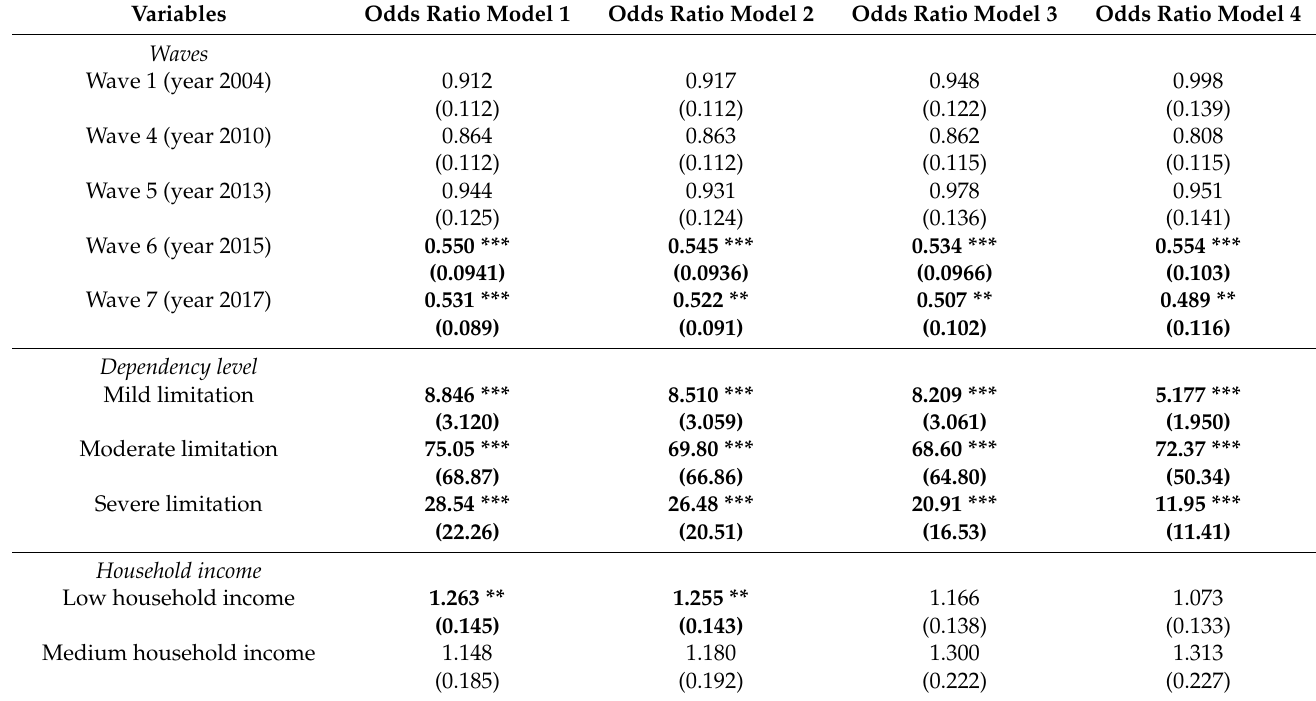
Table 4. Results from the logit regressions with random effects on informal care